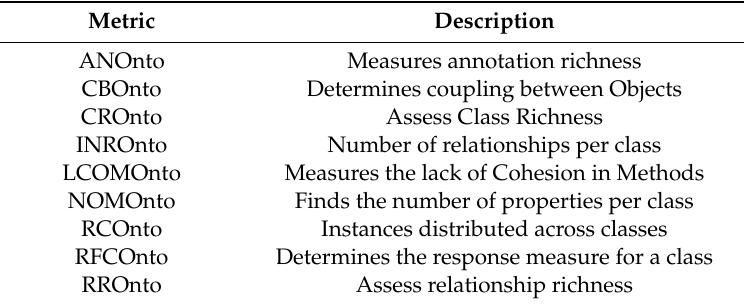
Table 1. Quality Metrics.